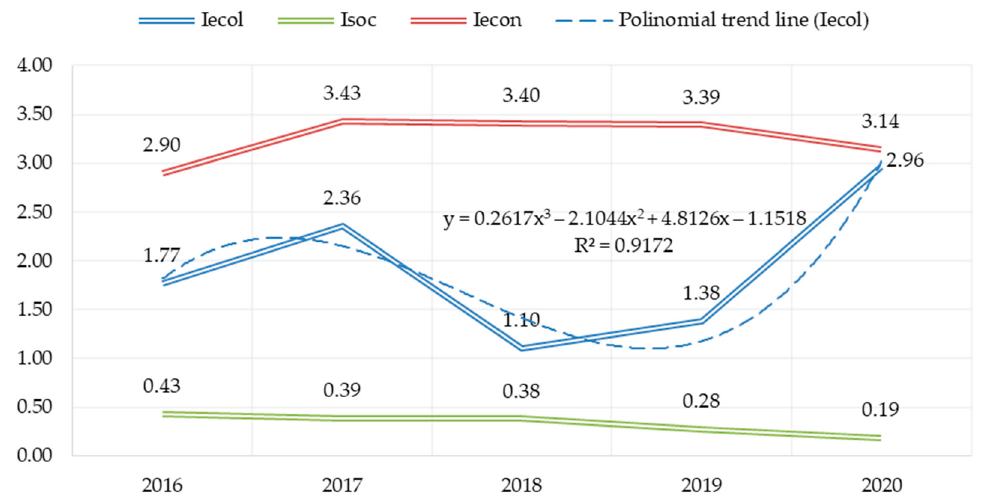
Figure 4. Values of sustainable development factors of PJSC «Nizhnekamskneftekhim» (calculated according to the author’s methodology).